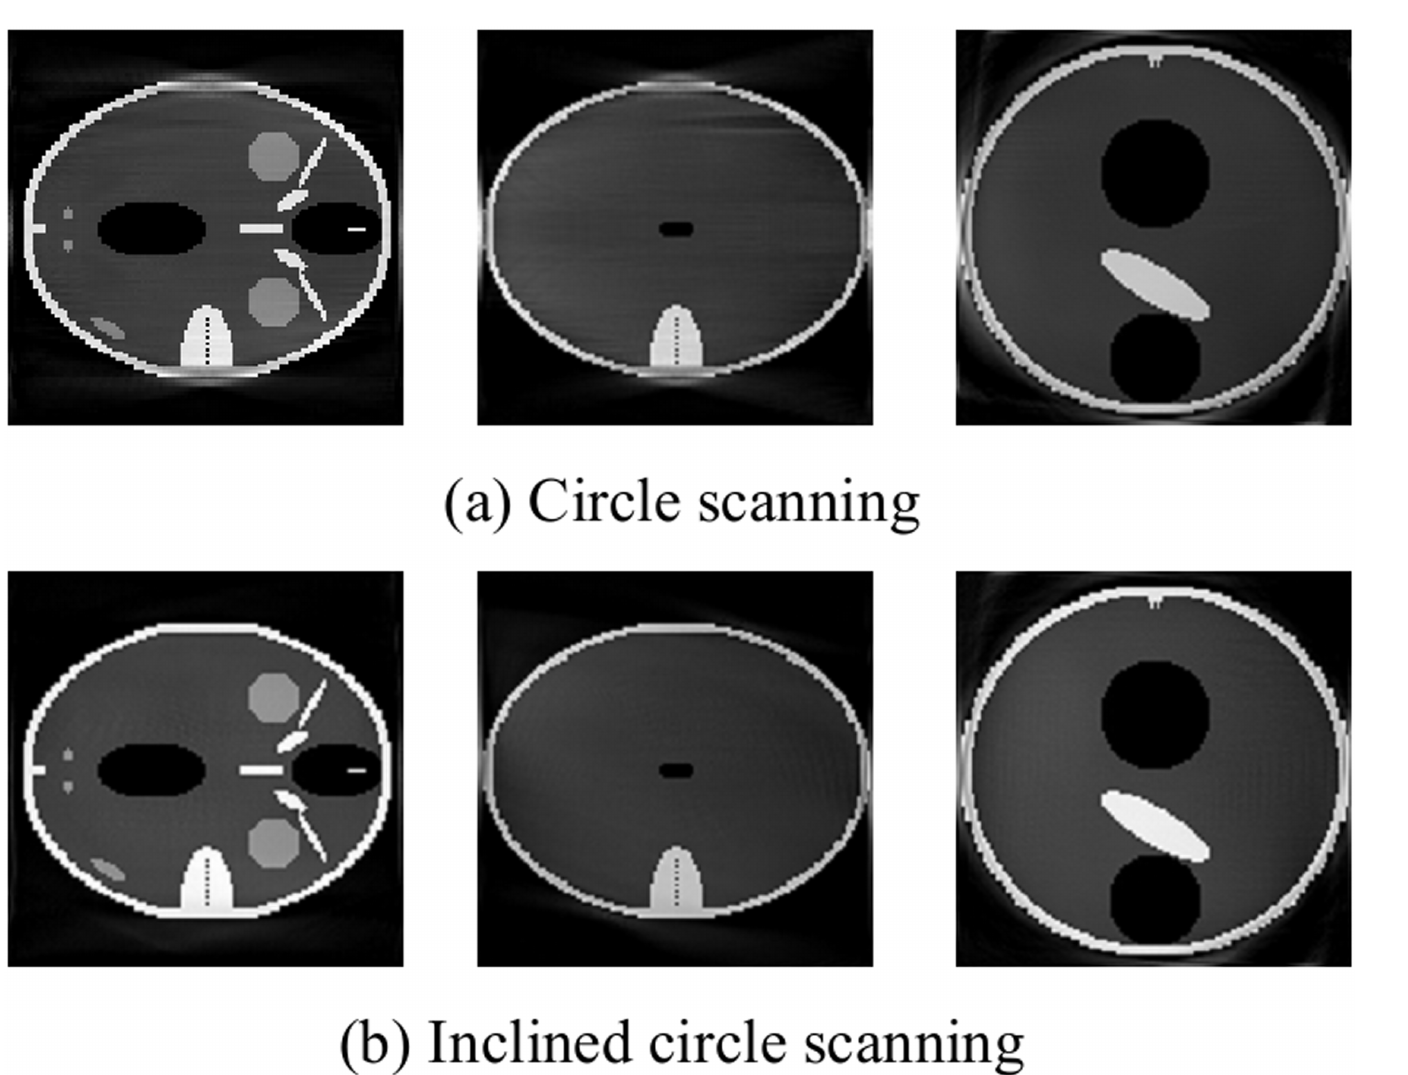
Fig 5. Slices of reconstruction image with larger cone